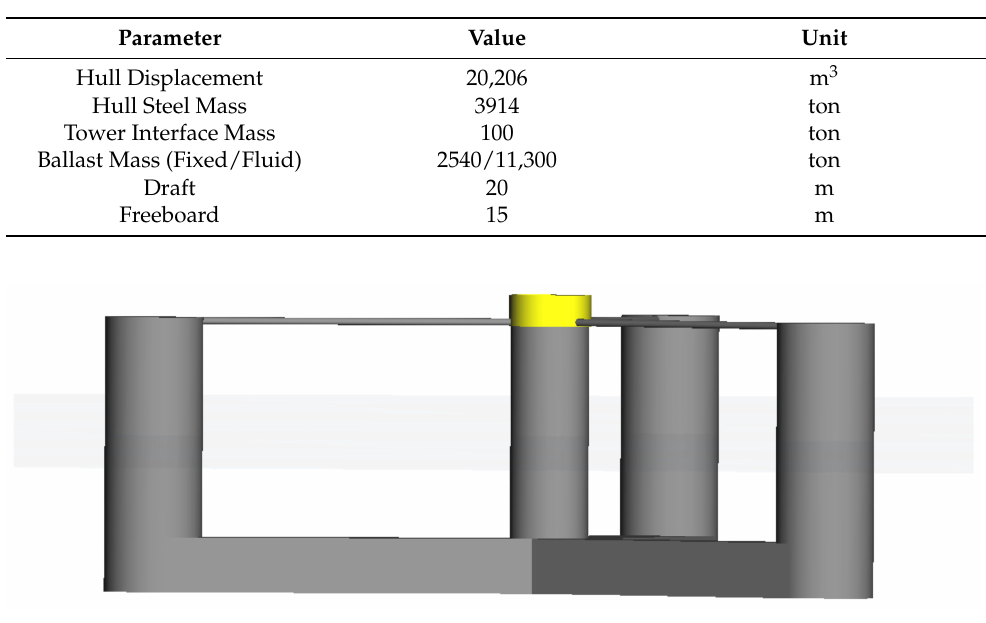
Figure 4. UMaine VolturnUS-S Semi-submersible platform modeling in